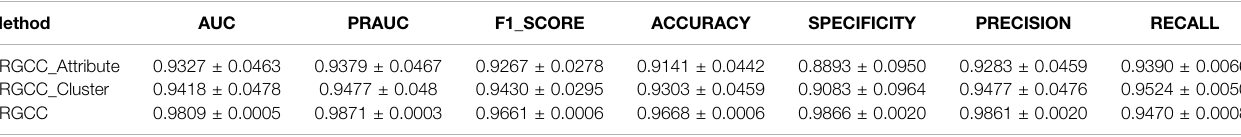
TABLE 2 | Comparison of different features on prediction